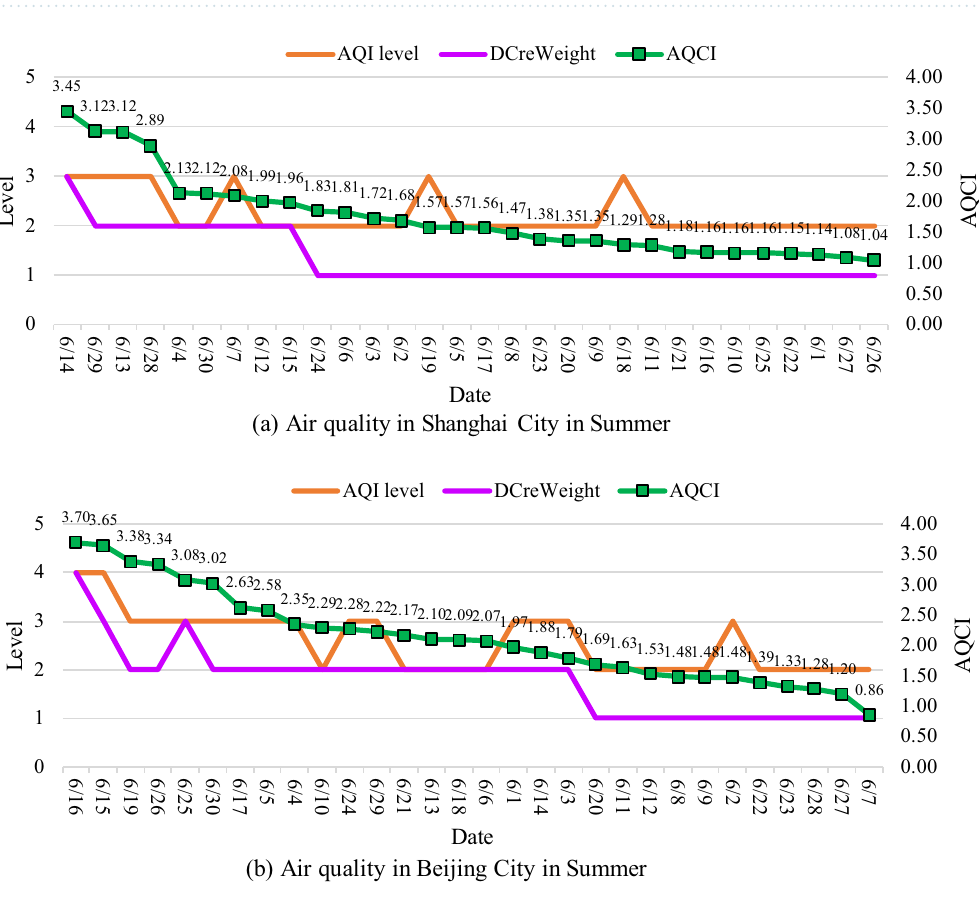
Figure 6. Air quality in Shanghai and Beijing City in Summer from June 1 to June